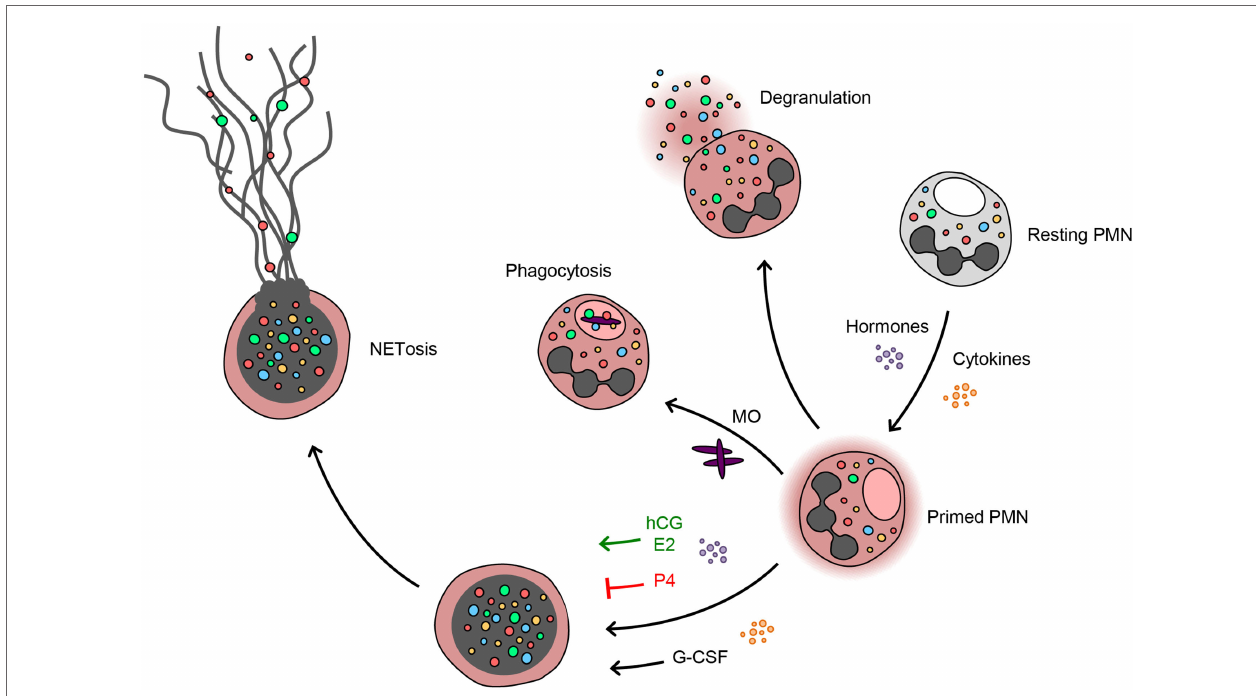
FigUre 6 | Progesterone antagonizes the estrogen and g-csF-driven neutrophil extracellular trap formation during pregnancy . Neutrophils during pregnancy lie under the increased influence of cytokines, e.g., G-CSF, and sex hormones. This specific milieu appears to poise the neutrophils in a pro-NETotic primed state. Depending on the stimulus, neutrophils react by phagocytosis or degranulation. When a different NETotic stimulus is present, such as systemic infection or excessive placentally derived plasma microparticles (MP) in preeclampsia (10), primed neutrophils react with overt NET release. Pro-NETotic combinations of hormones and cytokines are given in green, inhibitory combinations are given in